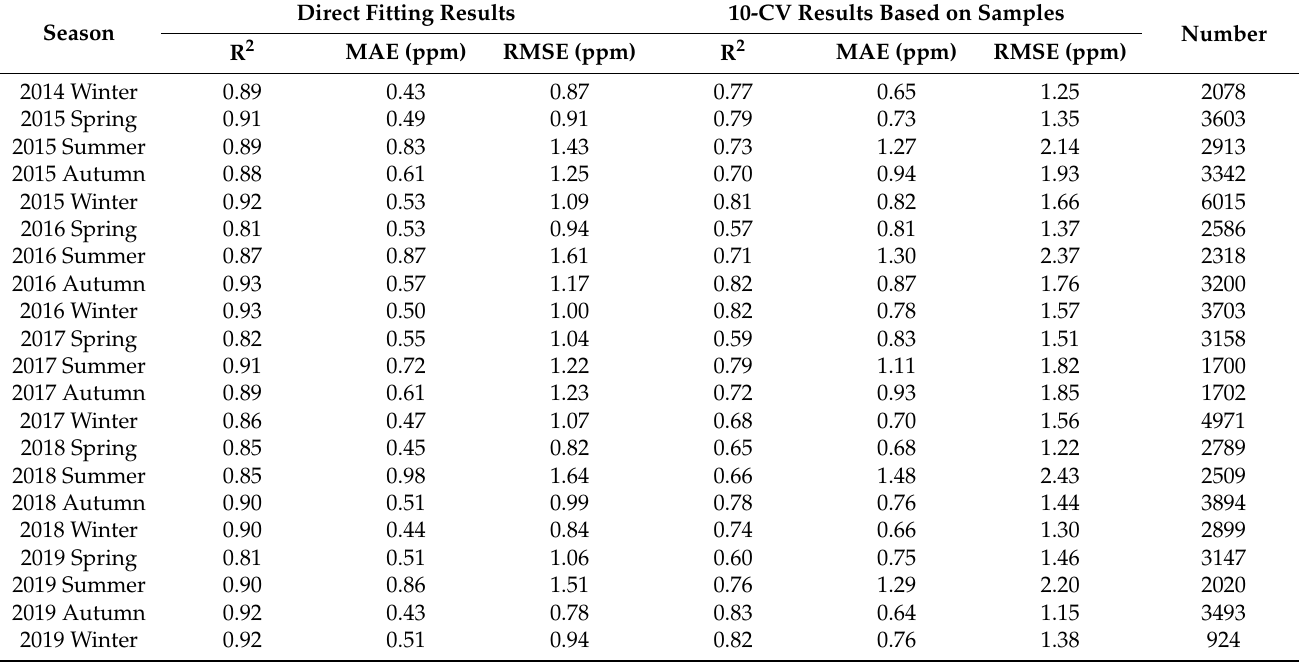
Table 3. Statistical results of seasonal accuracy of the model from 1 January 2015 to 31 December